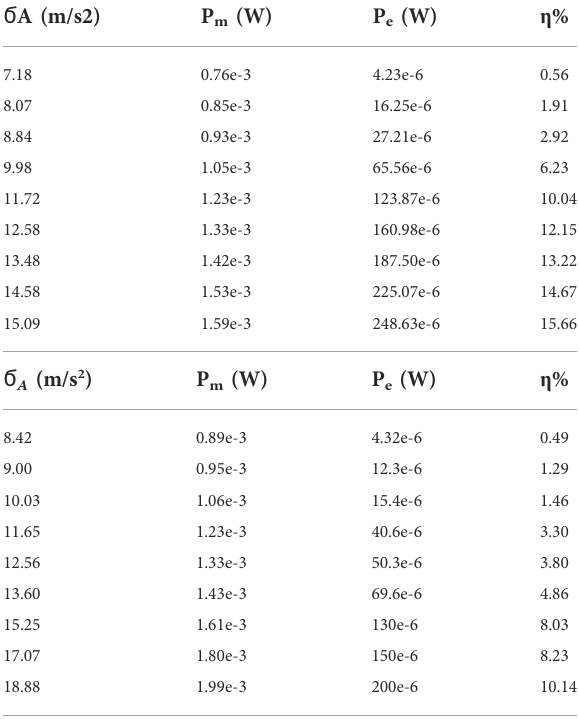
TABLE 6 Estimated ef fi ciency, the standard deviation of the acceleration Ϭ A , and the electrical and mechanical powers, P e and P m , for a) the “ constrained ” STB and b) the STB harvester discussed in [52], ( © 2019